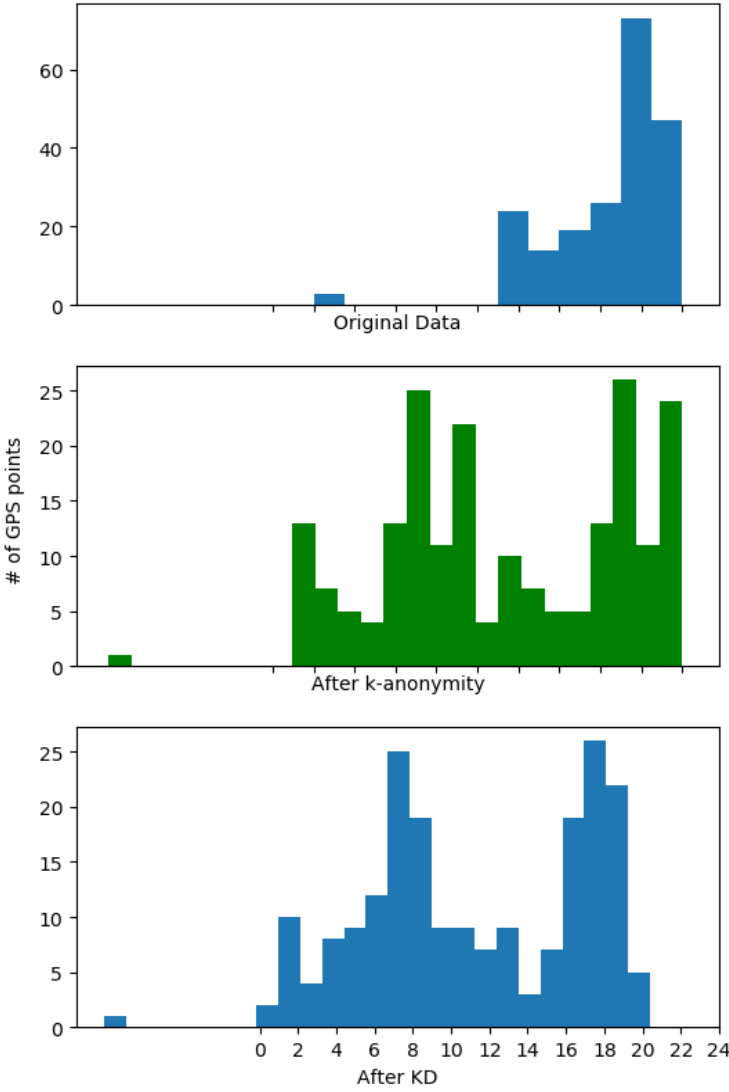
Figure 4. TDP for T-drive Taxi Trajectories dataset.